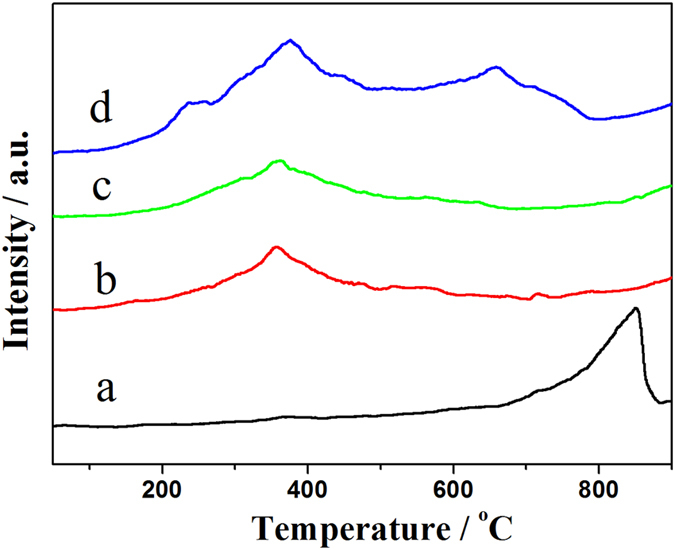
O2-TPD profiles of (a) LSM, (b) Pd/LSM-1, (c) Pd/LSM-2, (d) Pd/LSM-3.